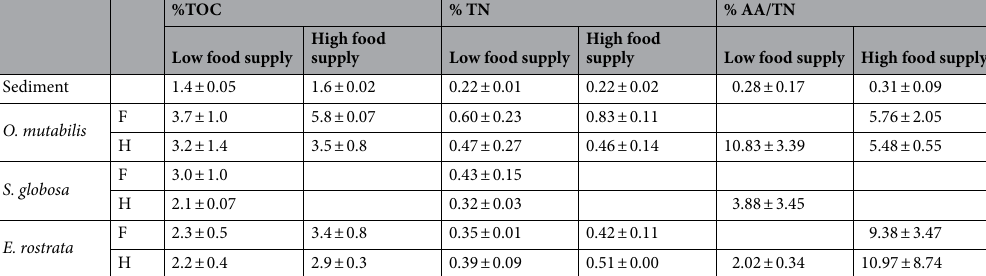
Table 1. Total organic carbon (TOC), total nitrogen (TN) and contribution of N (% dry weight) from AAs to TN in surface sediments (0–5 mm) and gut contents (F: foregut; H: hindgut) of deposit feeders (mean ± SD) collected in periods of low food supply (i.e. May) and high food supply (i.e. October). The sample size was two for each mean value.